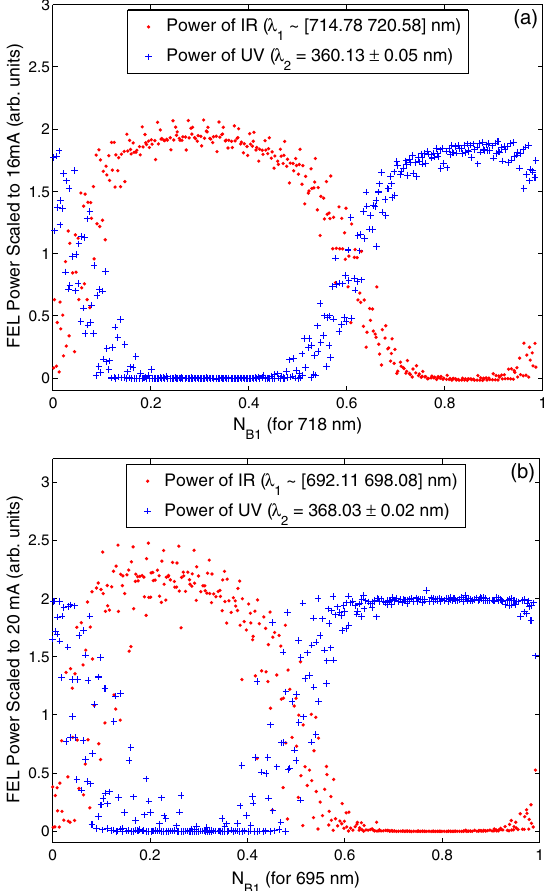
FIG. 9. Long-term FEL power measurements with the three- undulator configuration and loss curves L1 (Run 2). (a) Spectra and (b) FEL powers of two-color lasing. The narrow shaded regions in (b) represent the injection periods in which the data points are eliminated in the calculation of rms power variations. The beam current is maintained between 15.78 mA and 16.54 mA with top-off